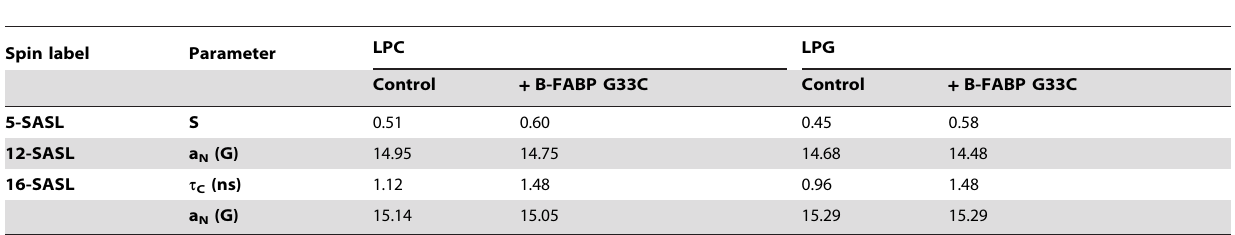
Table 1. Parameters determined from the ESR spectra of n -SASL spin label incorporated in the membrane mimetic (LPC or LPG) as discussed in Materials and